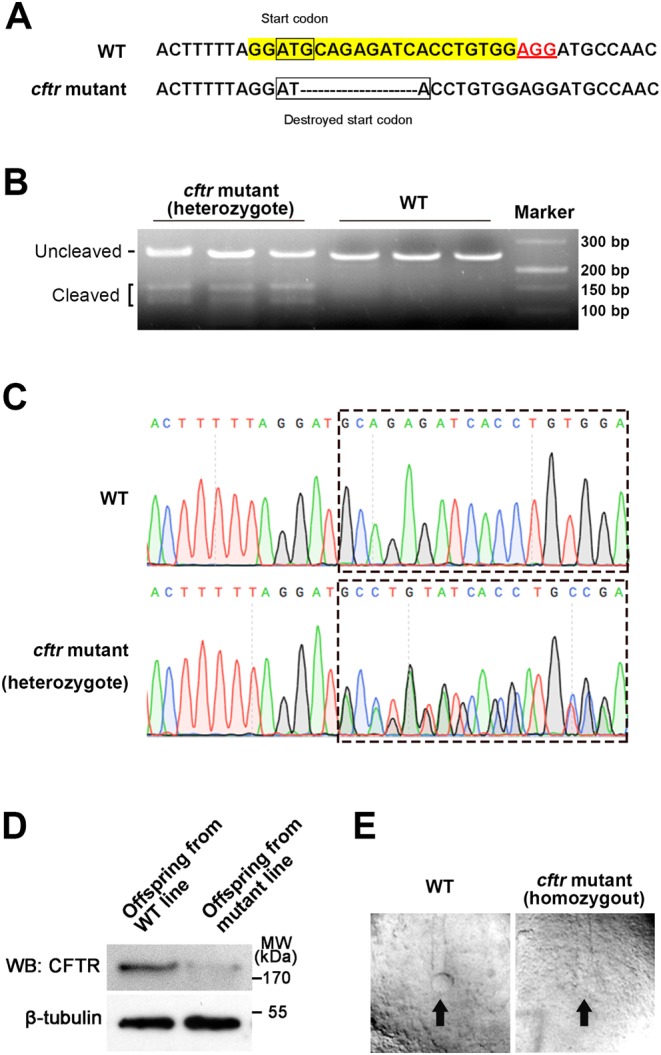
Targeted indel mutation induced by engineered Cas9/gRNA at the cftr gene in zebrafish. (A) The target sites highlighted by yellow and the PAM sequence marked by red underlined text. Deletions of cftr mutant are shown as dashes. Boxes show the start codon of WT and destroyed start codon of cftr mutant. (B) Gel shows T7E1 digestion of PCR products amplified from adult tail genomic DNA of F1 heterozygous generation. The uncleaved and cleaved PCR products are indicated. After digestion with T7E1, the cleaved PCR product of the adult tail represents the fragments containing the mutation. (C) Sequencing results show that F1 heterozygous generation fish carrying cftr mutant produces overlapping peaks marked by dashed box. (D) Western blot assay indicates the significant reduced Cftr protein level in offspring embryos from mutant line. (E) The got genotyped homozygous cftr mutant embryo also demonstrated the absent of Kupffer’s vesicle (KV) lumen (pointed by arrow) at 8-somite stage.